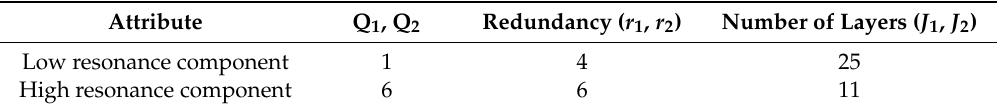
Table 5. The sparse decomposition parameters of case